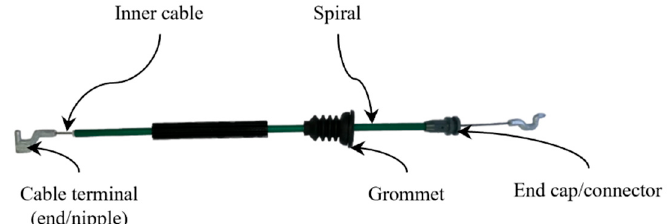
Figure 1. Control cable and its main parts and accessories.